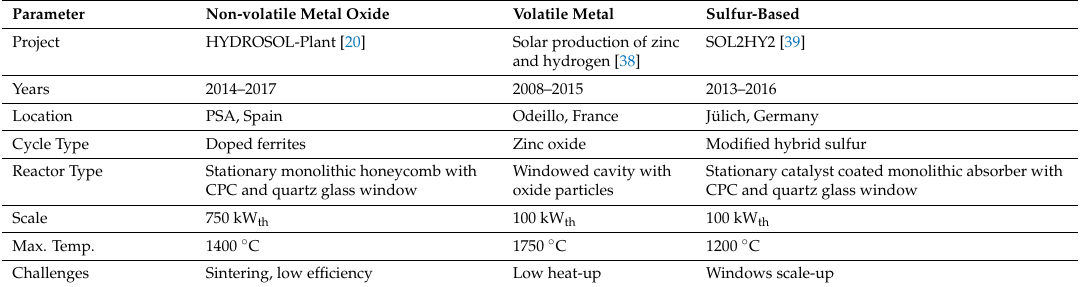
Table A1. Demonstrations of solar thermochemical hydrogen production (adapted from [17]).